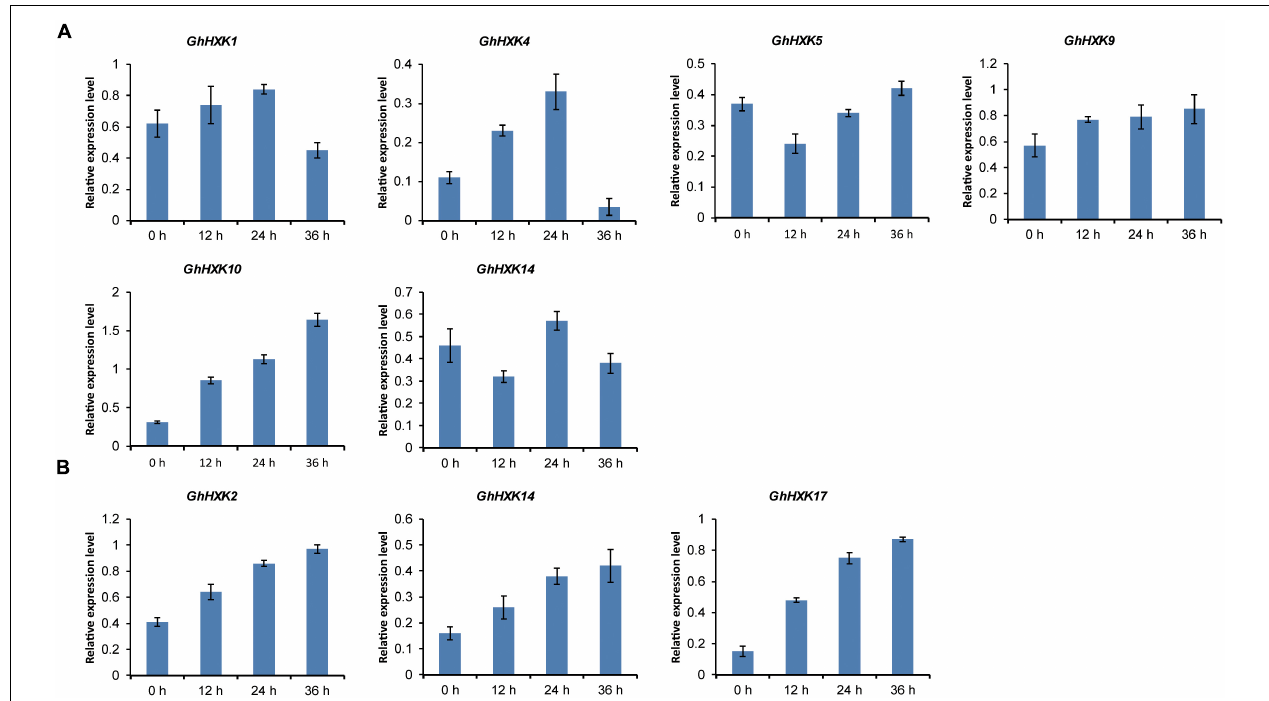
FIGURE 10 | GhHXKs expression levels are induced by GA (A) and auxin (B) analyzed by qRT-PCR. GA treatment induced expression of most GhHXKs with GARE-motif, P-box or TATC-box in their promoter regions (A) . The relative expression levels of GhHXKs with AuxRR-core or TGA-element in their promoter regions (B) . The error bars represent means ± SE from three independent biological repetition. The y -axis represents the relative expression level. The x -axis represents the 0 DPA ovules treated with GA or IAA for 0, 12, 24, and 36 h, respectively.